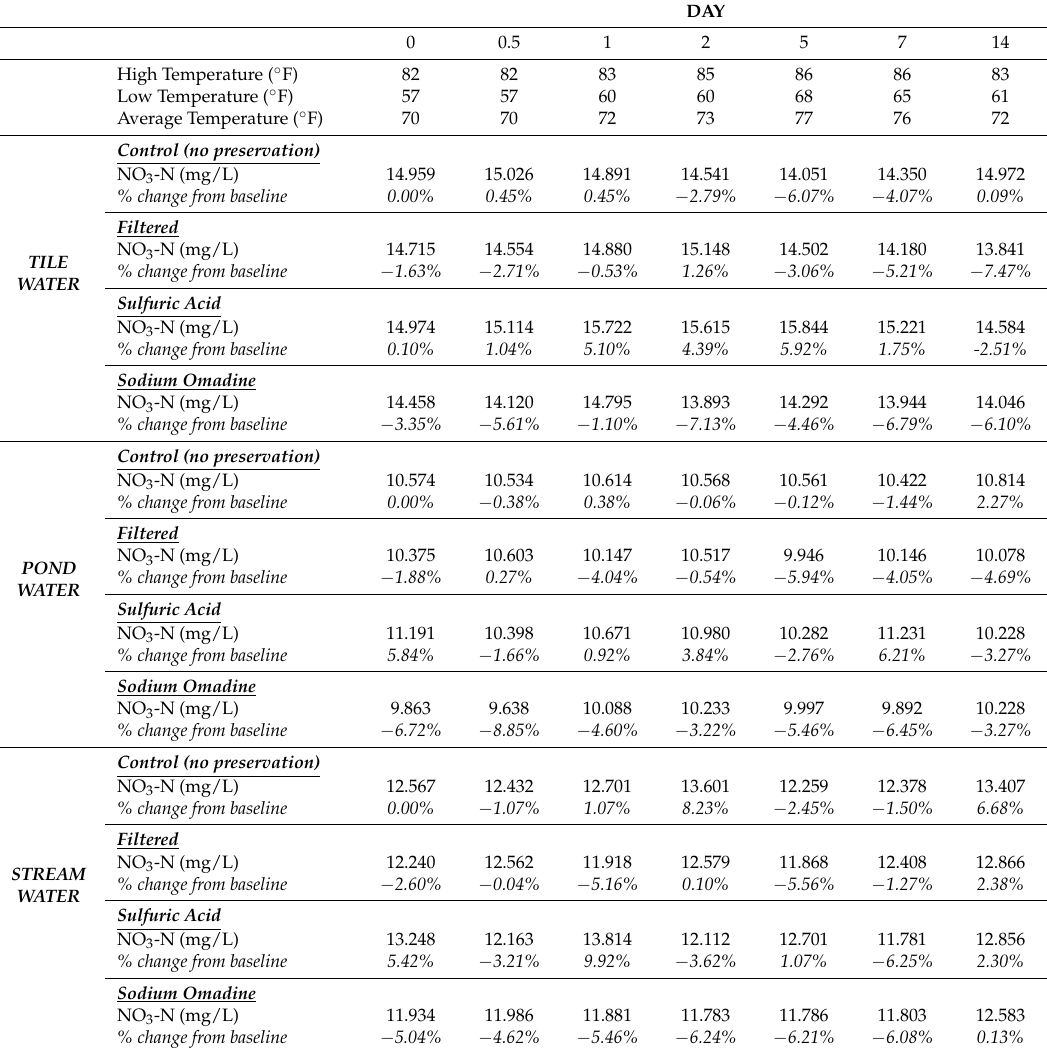
Table 3. Daily high and low temperature that water samples were exposed to, as well as the nitrate-N concentrations and % change from the baseline concentration. The baseline concentration is the Day 0 Control for each water